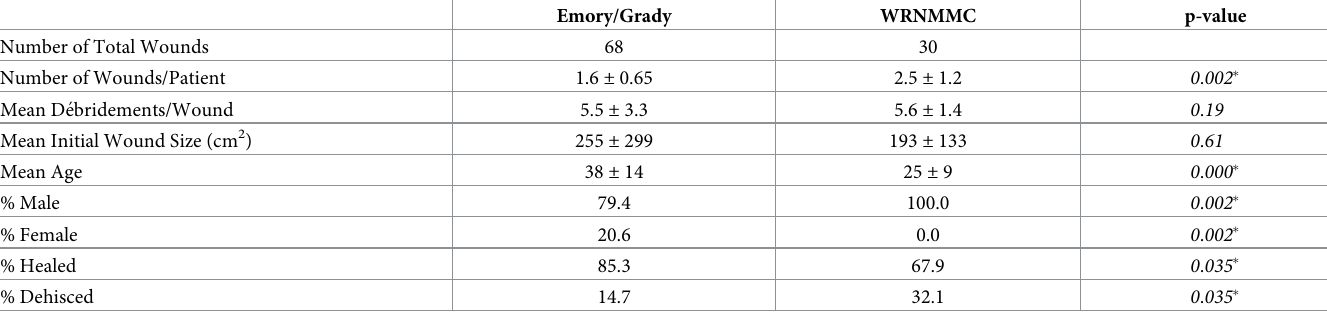
Table 1. Patient demographics by institution (Emory/Grady versus WRNMMC).